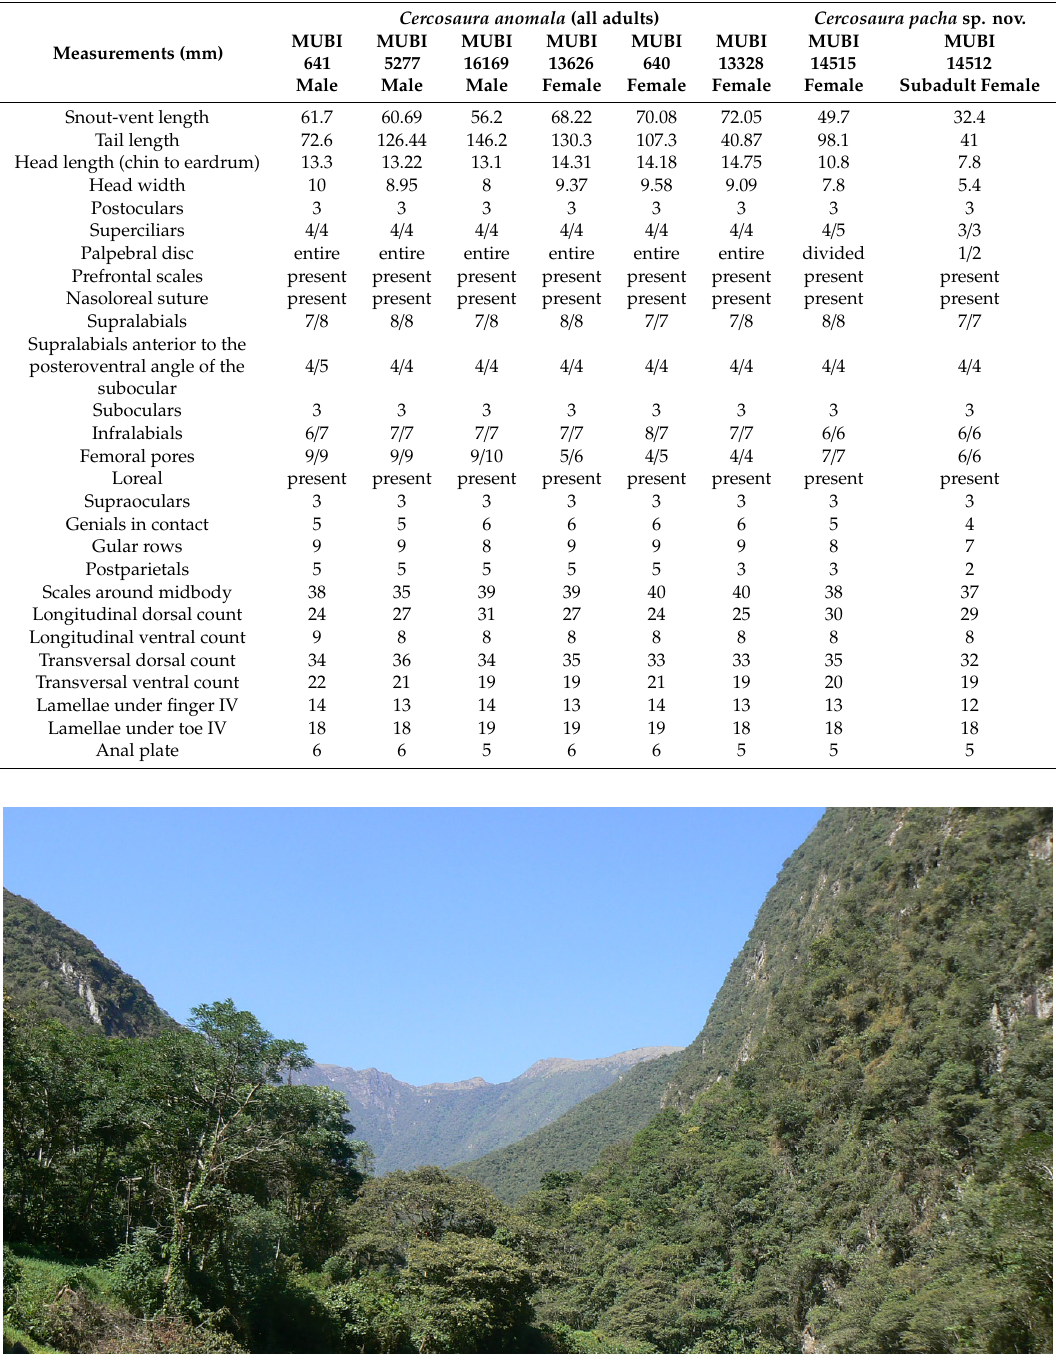
Measurements (mm)